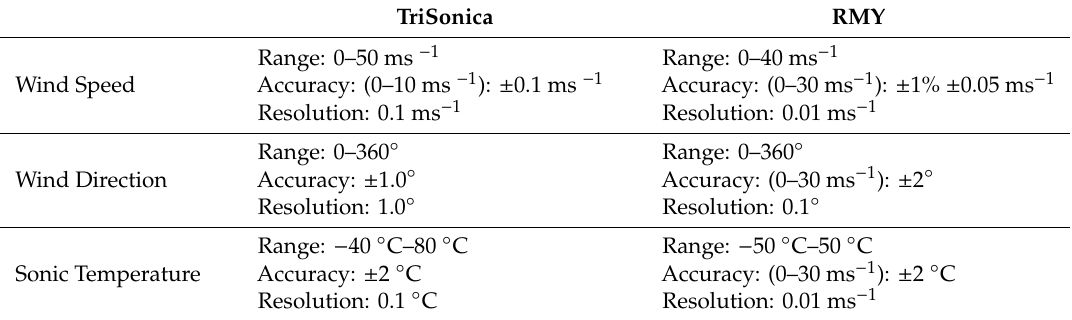
Table 1. Specifications of TriSonica and RMY sonic